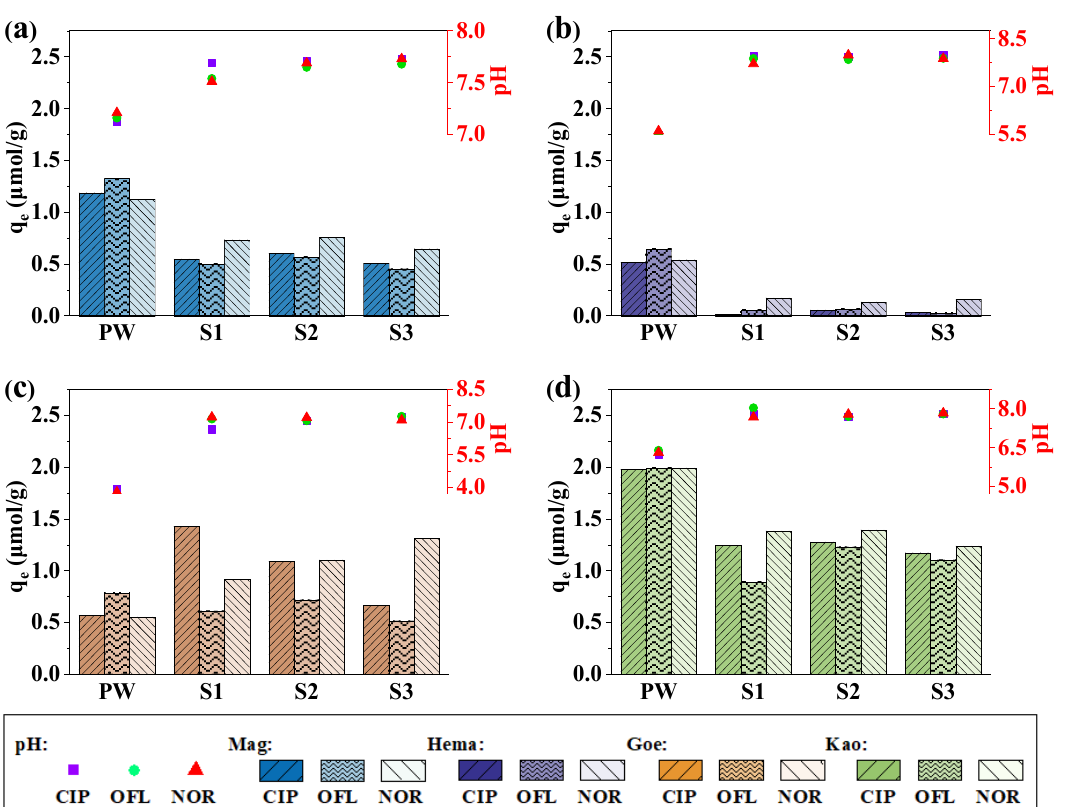
Figure 8. Adsorption of CIP, OFL and NOR on ( a ) Mag, ( b ) Hema, ( c ) Goe, and ( d ) Kao in the media of surface water. Bars represent the adsorption amount, and points represent the ending pH of the solution after the adsorption. Conditions: [CIP] 0 = [OFL] 0 = [NOR] 0 = 10 μ mol/L, dosage of solids = 5 g/L, PW means 10 mL ultrapure water, S1–S3 were mixtures of 2 mL antibiotic stock solution and 8 mL collected natural surface water.